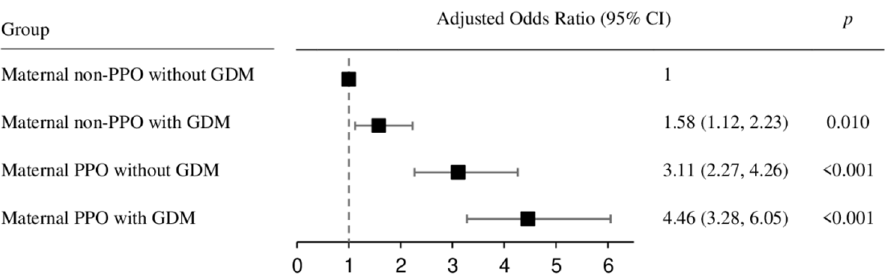
Figure 4. Adjusted odds ratio. CI: confidence interval, PPO: pre-pregnancy obesity, GDM: gestational diabetes mellitus.